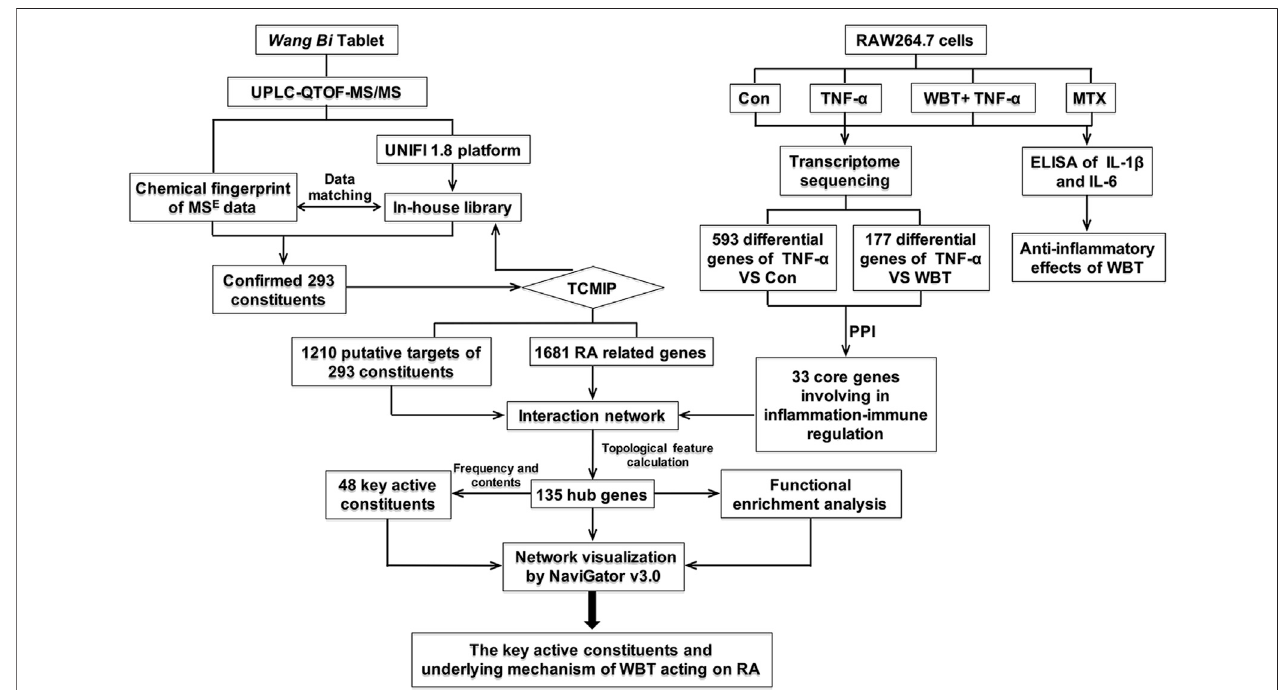
FIGURE1| Theschemeofthepresentstudybasedonthe “ integrativepharmacologystrategy ” toelucidatethemainactivecomponentsandmechanismofWBTin treating RA.